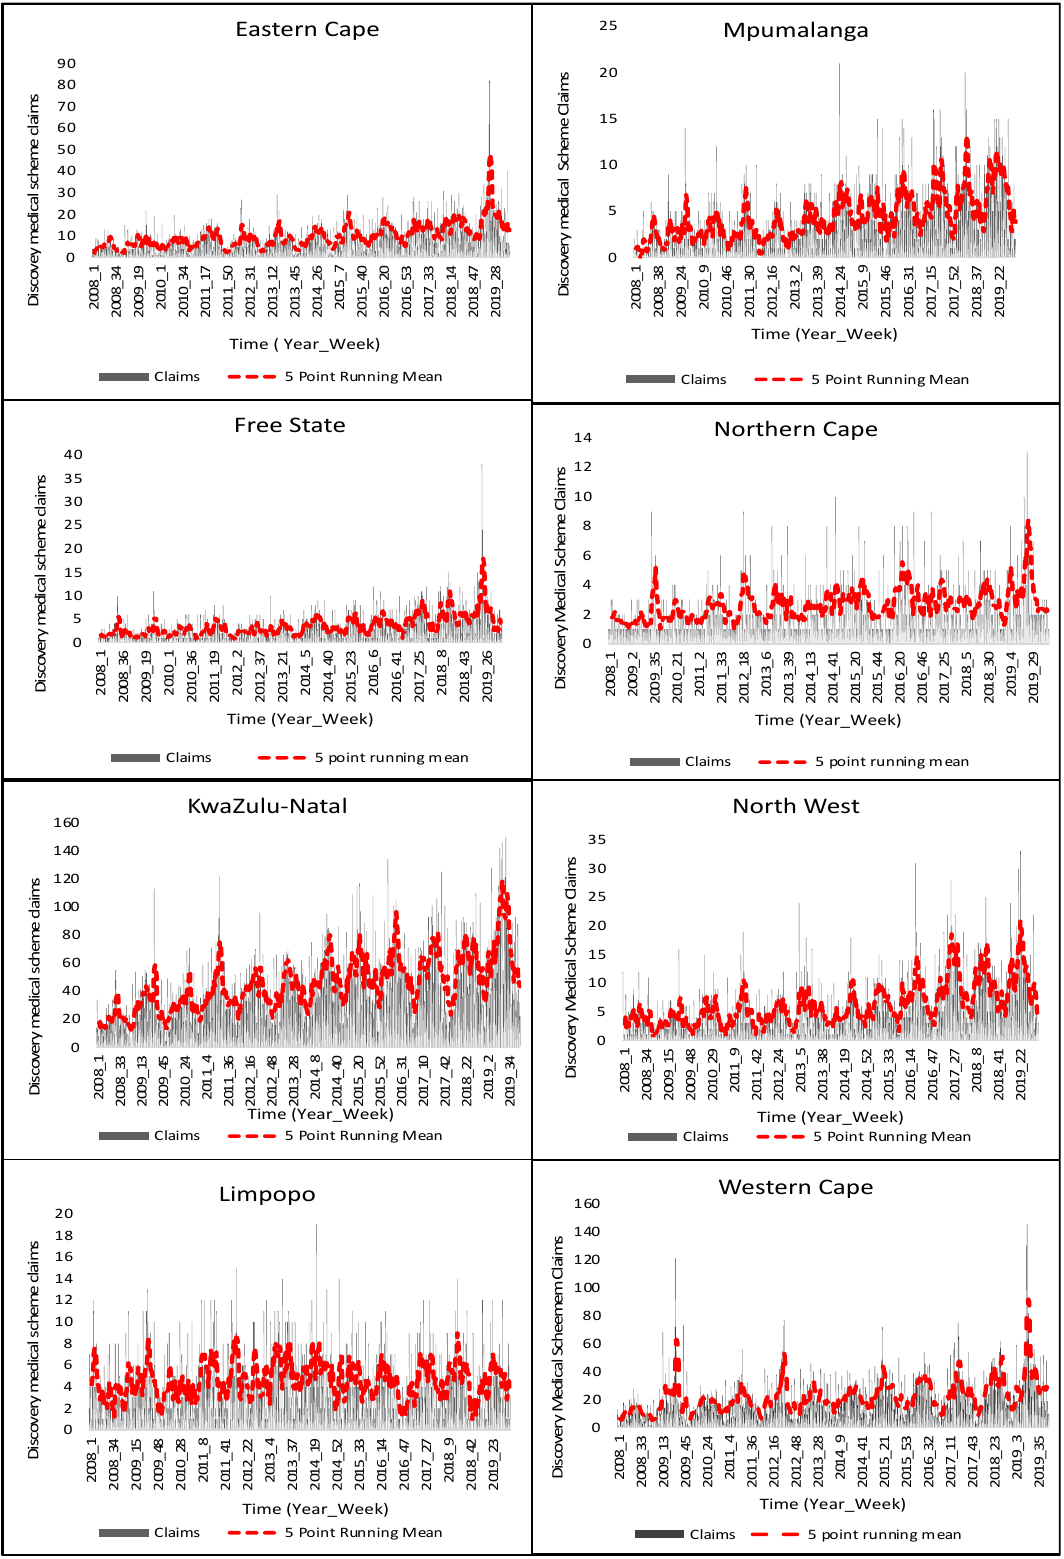
Figure 5. Medical insurance claims and running mean for Eastern Cape, Free State, KwaZulu-Natal, Limpopo, Mpumalanga, Northern Cape, North West Province, and Western Cape. Limpopo, the northernmost province of South Africa, exhibits no seasonal pattern in claims as the claims peaked in both peak and off-peak seasons from 2008 to 2019 (Figures